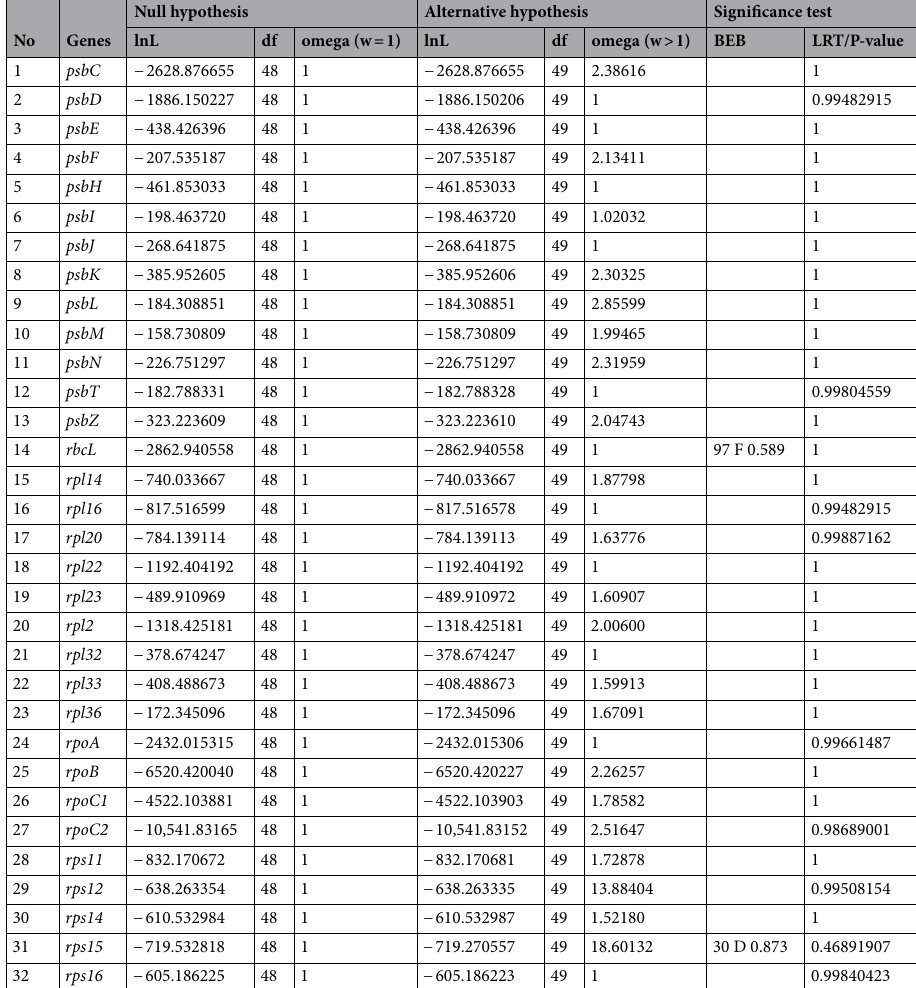
Table 2. The potential positive selection test based on the branch-site